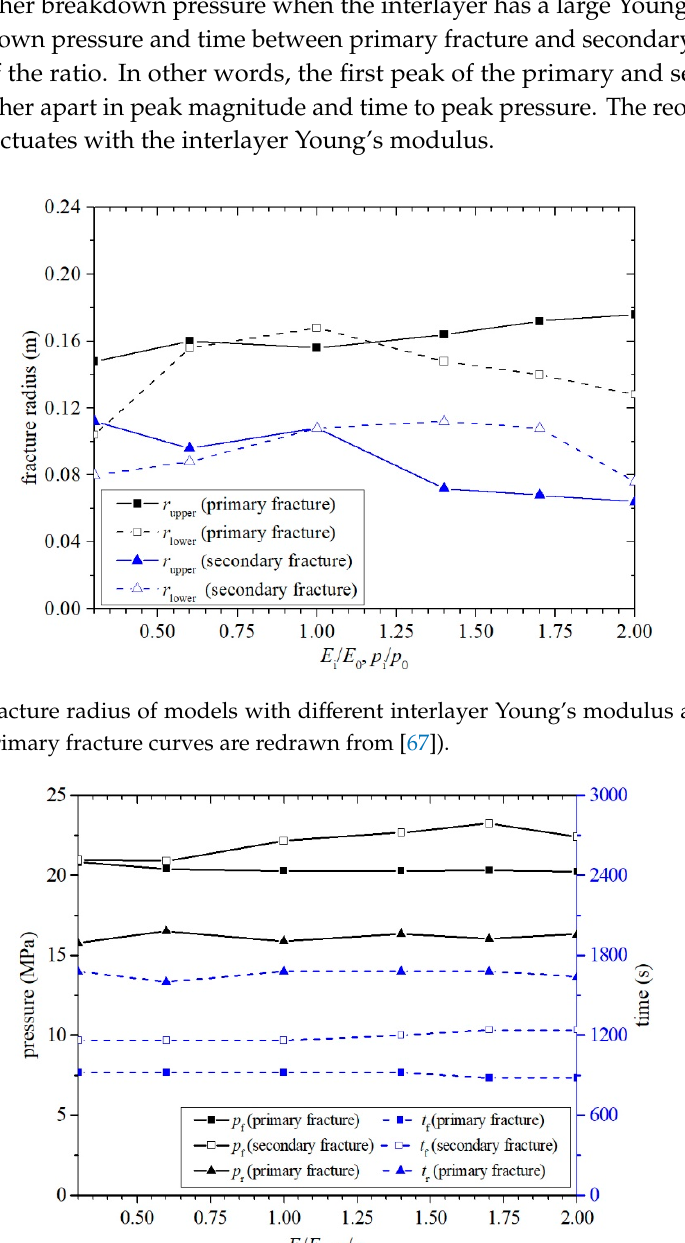
Figure 8. The breakdown pressure / time and reopening pressure / time of fractures in models with different interlayer Young’s modulus and strength.